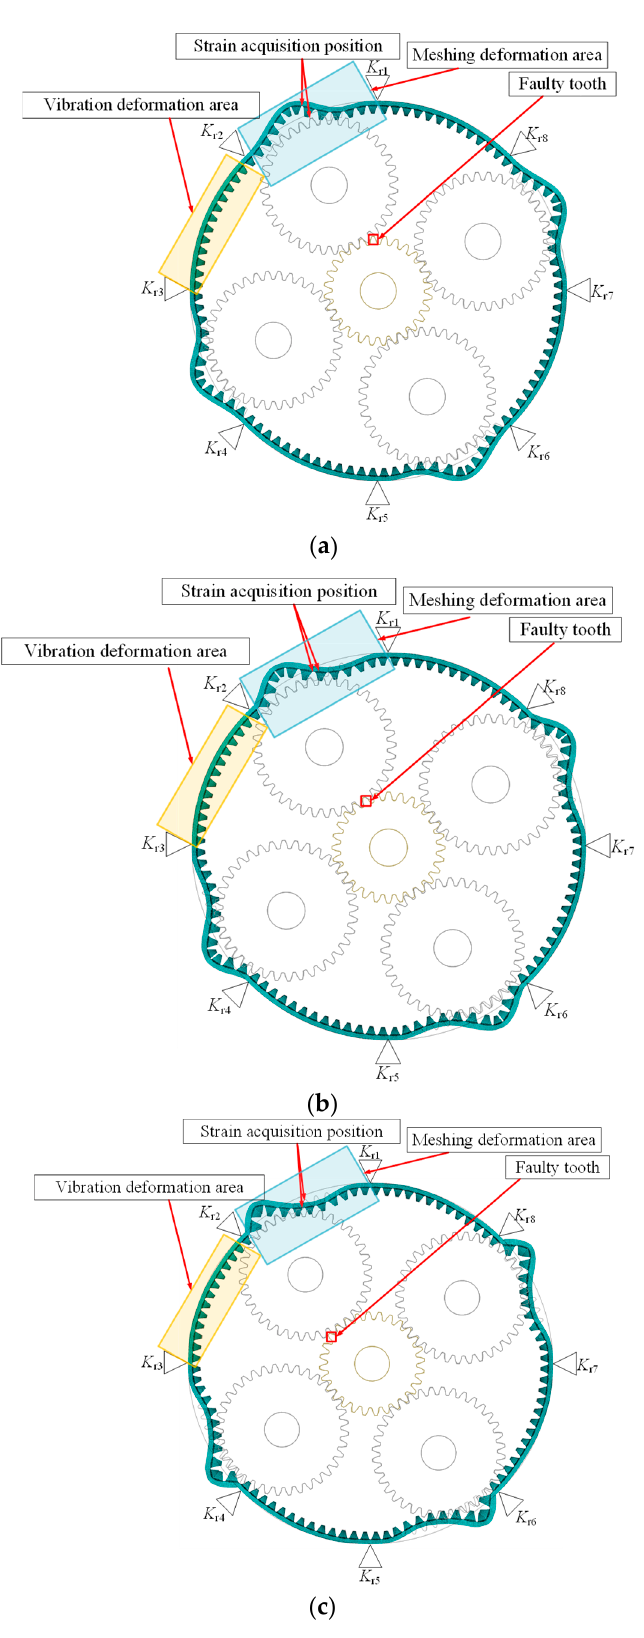
Figure 15. ( a ) The planetary gear is about to snap into the faulty tooth inner ring deformation. ( b ) Planetary gear meshing fault inner ring deformation. ( c ) The inner ring is deformed before the planetary gear gnawing the faulty tooth.